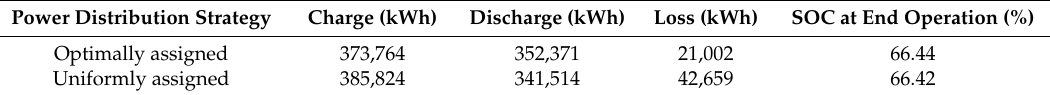
Table 3. FR operation comparison between the uniformly and optimally assigned power